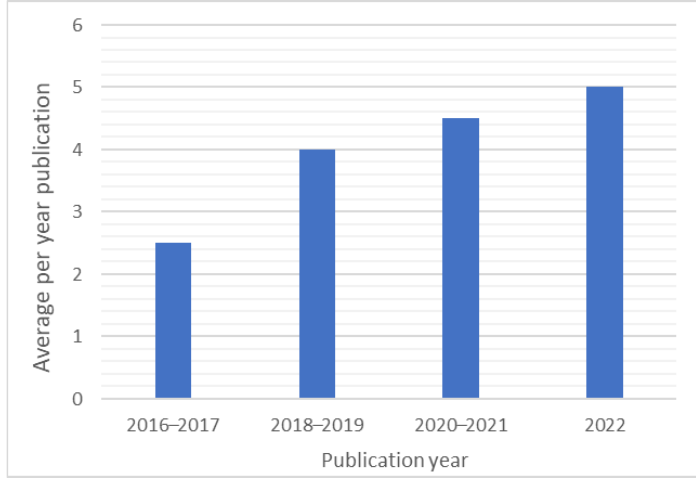
Figure 6. Distribution of the selected papers by year.